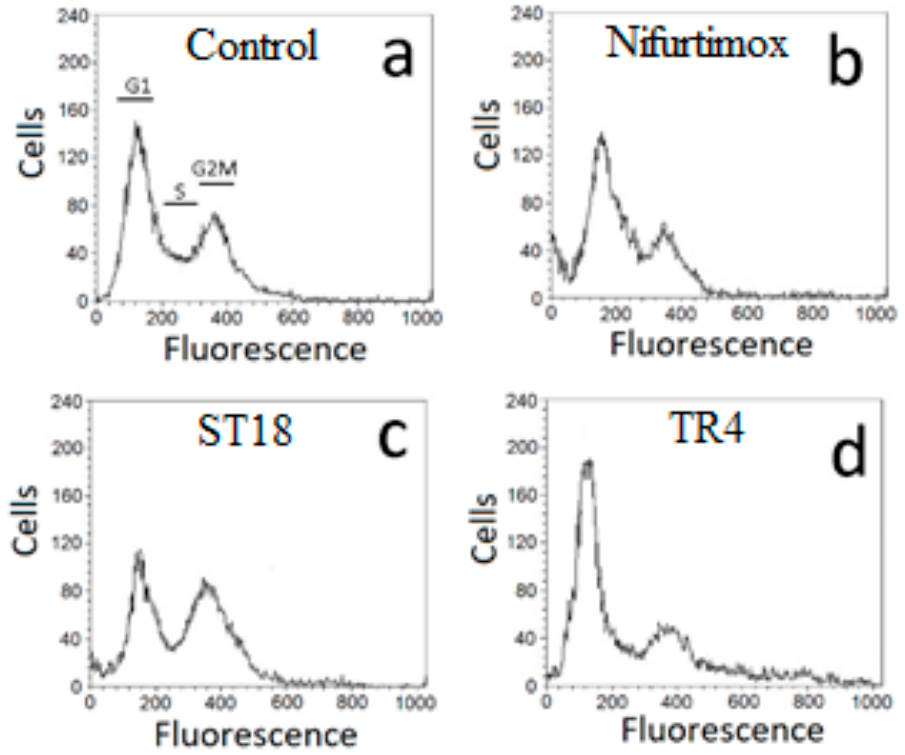
Figure 3. Effects of Nifurtimox, ST18 and TR4 on DNA content in/number of Trypanosoma cruzi epimastigotes. The parasites were cultured without compound (control, Panel ( a ) or with 35 µM Nifurtimox (Panel ( b ), 50 µM ST18 (Panel ( c ) and 90 µM TR4 (Panel ( d ). Cell cycle distribution was analyzed using the standard propidium iodide procedure. G1, S and G2–M cells are indicated in (Panel a ).